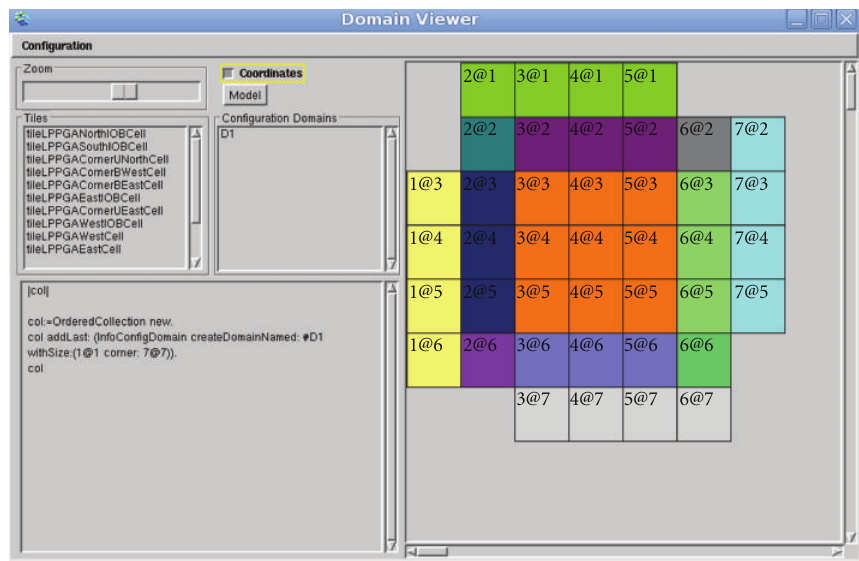
Figure 3: On the right, view of the di ff erent cell types composing the matrix (border cells, middle cells, IO cells). On the left, configuration domains are defined as a set of rectangular boxes. They can be reconfigured independently from each